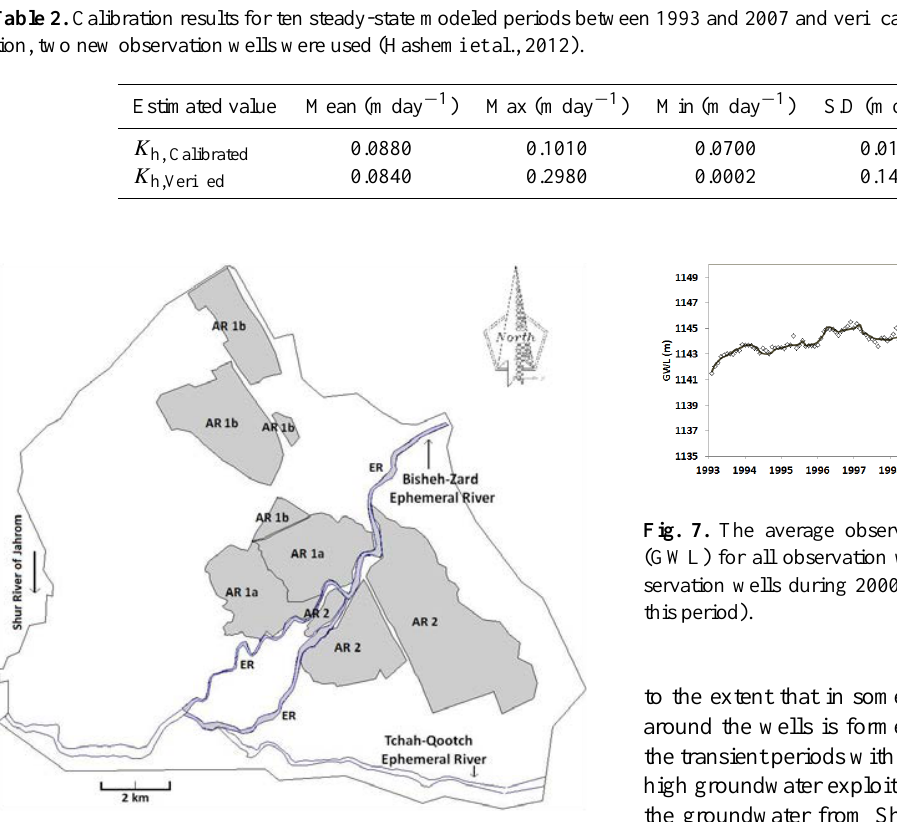
Fig. 6. Location of recharge zones in the GBP, artificial recharge (AR) 1a with 420 ha area established in 1983, AR 1b with 600 ha area established in 1996, AR 2 with 970 ha area established in 1983, and ephemeral river channel (ER).